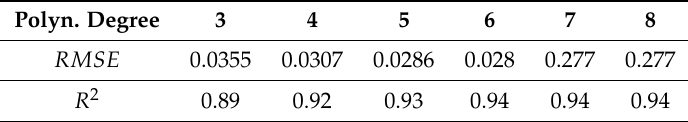
Table 2. R 2 and RMSE for polynomials of degrees from 3rd to 8th.